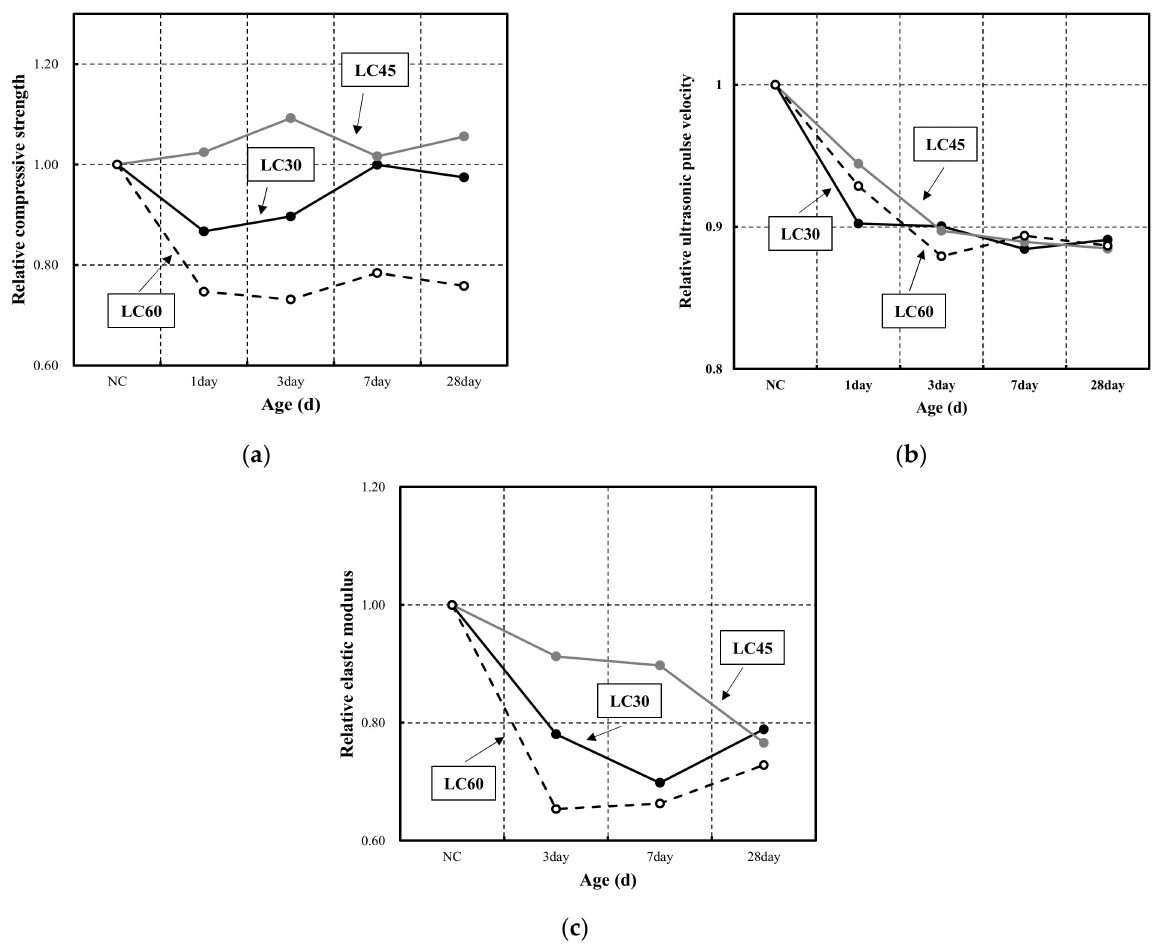
Figure 5. Relative mechanical properties between normal aggregate concrete and lightweight aggre- gate concrete at different ages: ( a ) relative compressive strength; ( b ) relative ultrasonic pulse velocity; ( c ) Relative elastic